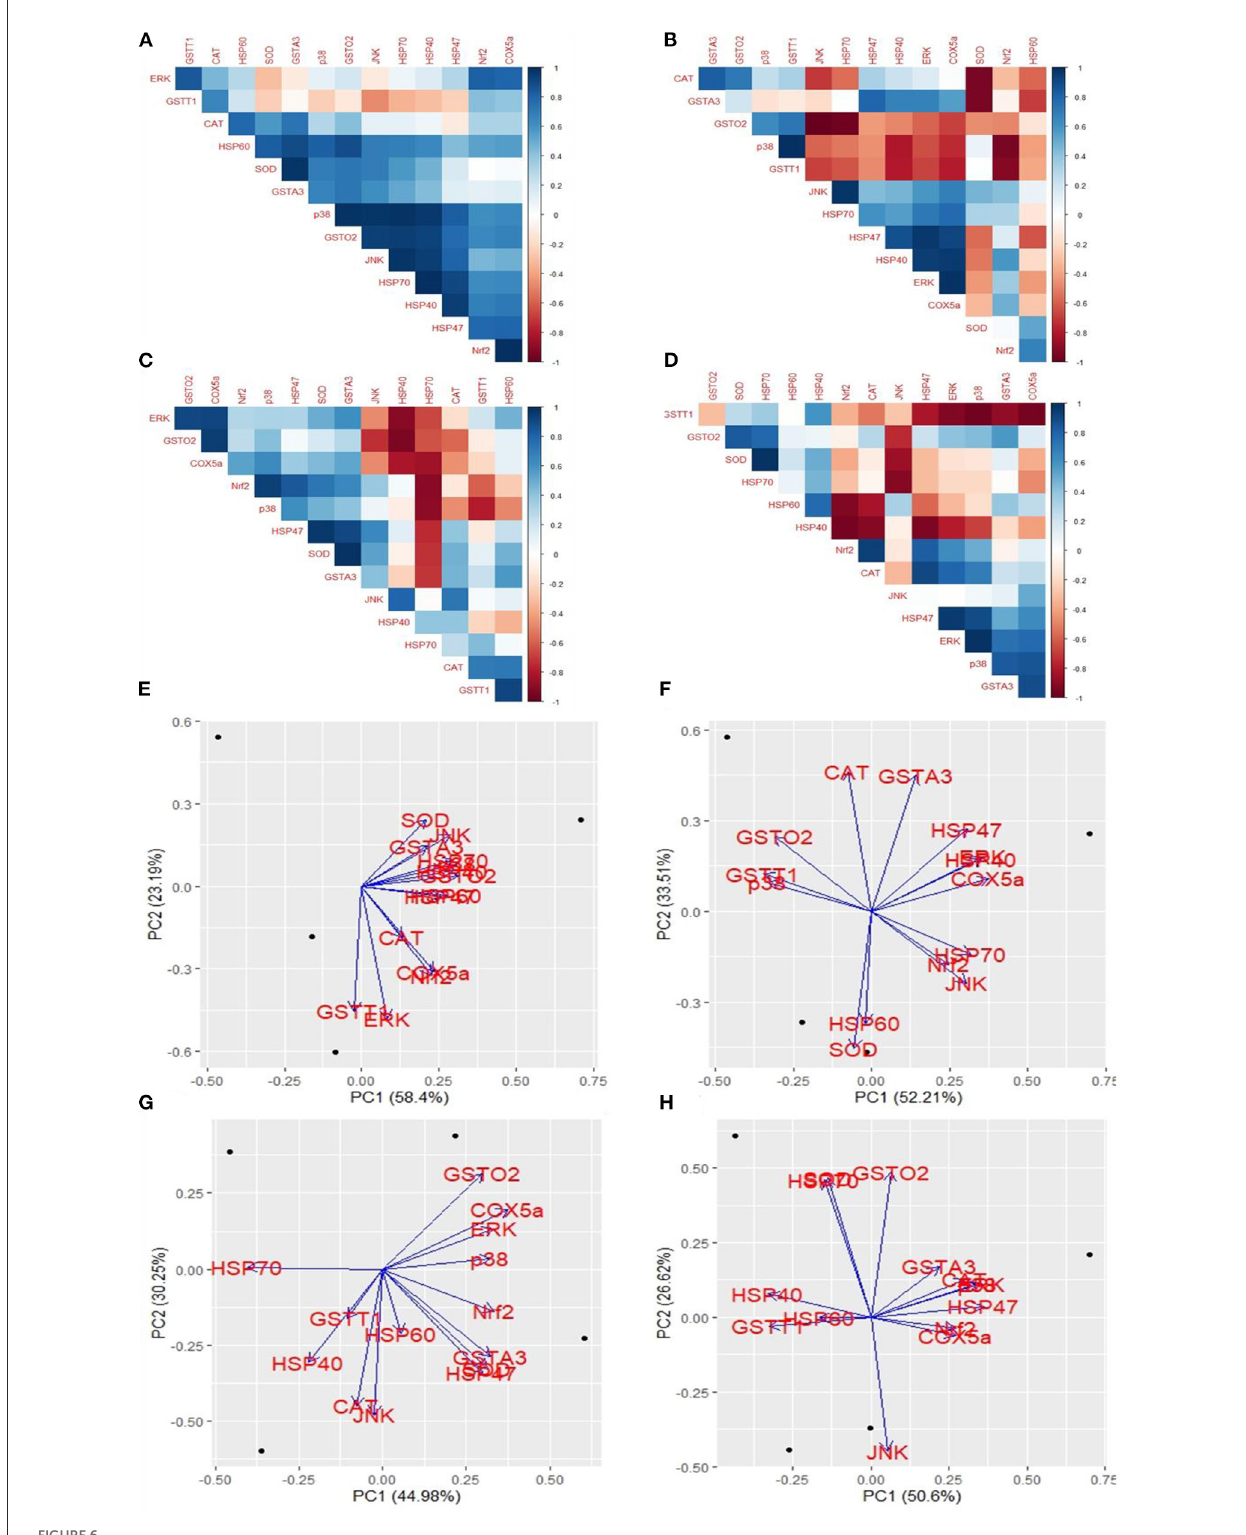
FIGURE6 Effects of COPA3 on the relationship between heat and MAPK/ERK-Nrf2 mRNA expression in fibroblasts. Correlations among the mRNA expression levels of the antioxidant enzymes, heat shock proteins, and the MAPK/ERK-Nrf2 related gene. (A) Control- group, (B) Control + group, (C) Heat Stress + group, and (D) Heat Stress- group. Principal component analysis (PCA) of the mRNA expression levels of the antioxidant enzymes, heat shock proteins, and the MAPK/ERK-Nrf2 related gene. Based on the position of the different genes on the X and Y axis predict the relation among different genes in particular group. (E) Control- group, (F) Control + group, (G) Heat Stress + group, and (H) Heat Stress- group. PC1 and PC2 were selected as they explained the most